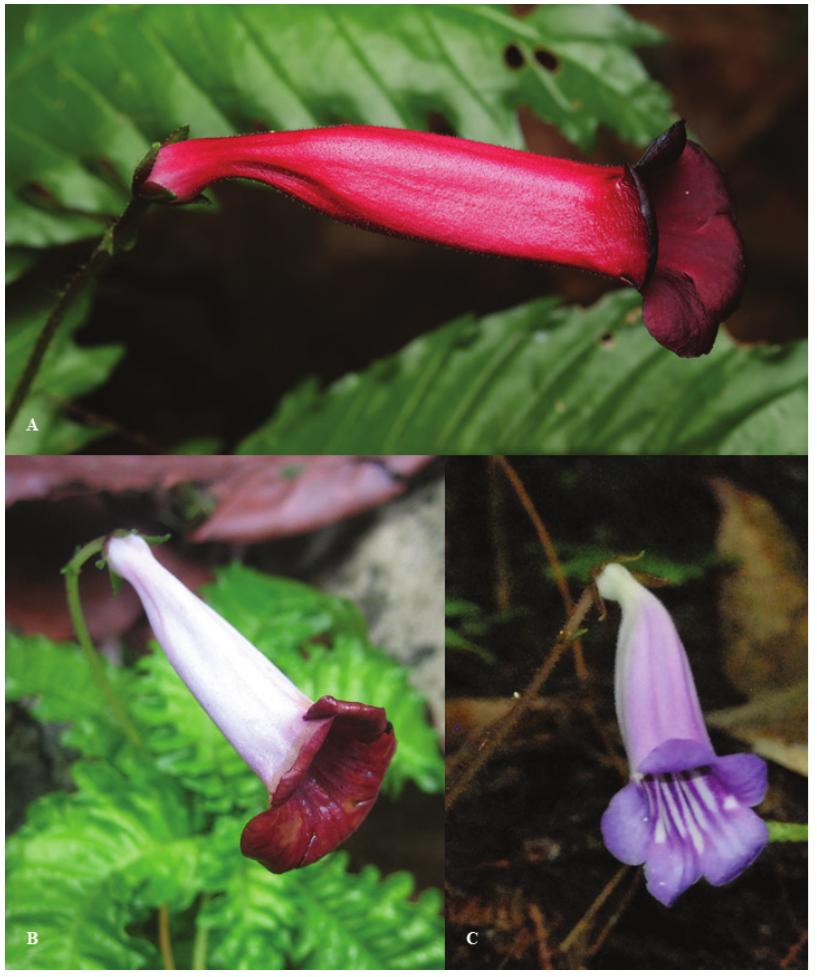
Figure 5. Comparison flowers of resembles species A Ridleyandra merohmerea B Ridleyandra iminii C Ridleyandra morganii (Photo by A Zaharil D B – C Siti-Munirah